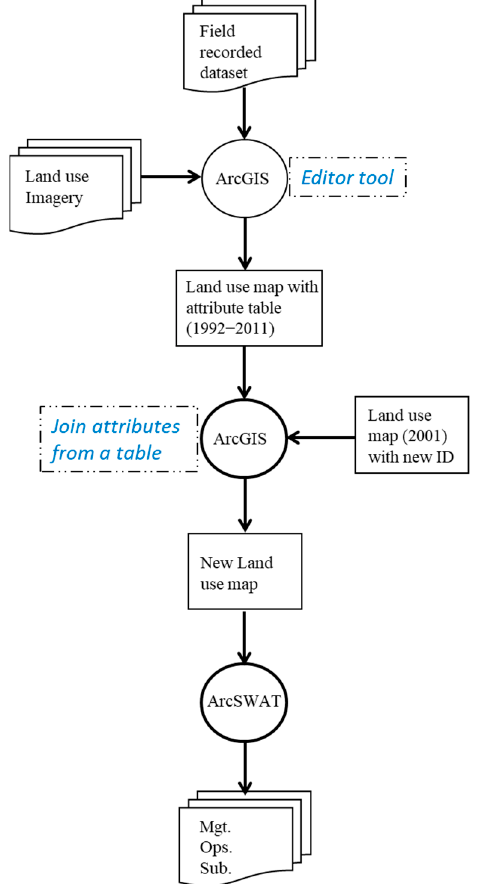
Figure 4. Flowchart of the new land use map generation and detailed land use and management information incorporated into SWAT1. “Mgt”, “Ops”, and “Sub” stand for management and operation and subbasin input files.